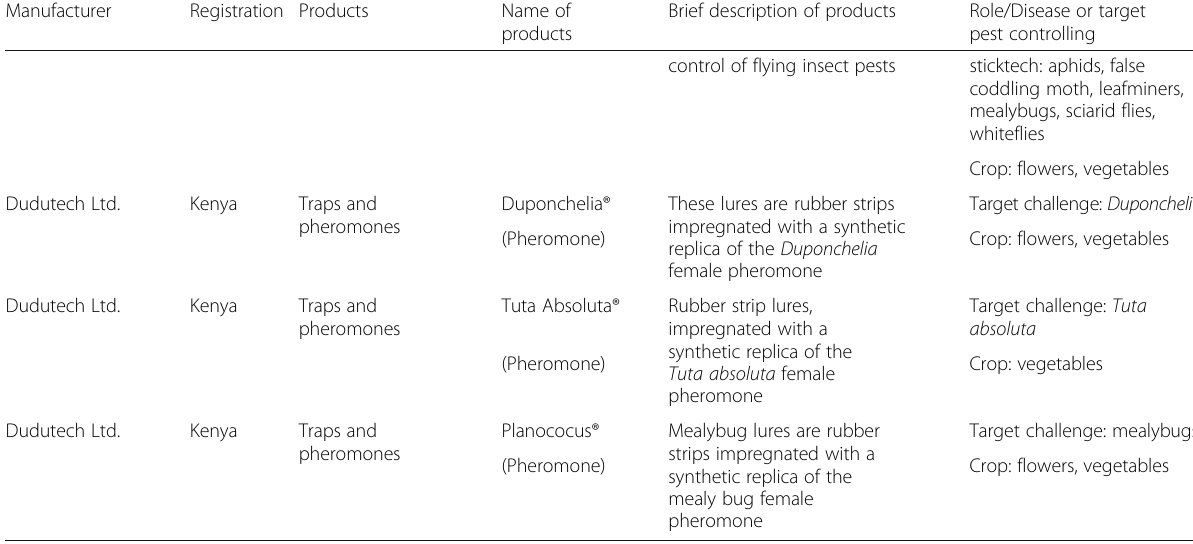
Table 2 Presentation of manufacturers in Africa and commercialized products